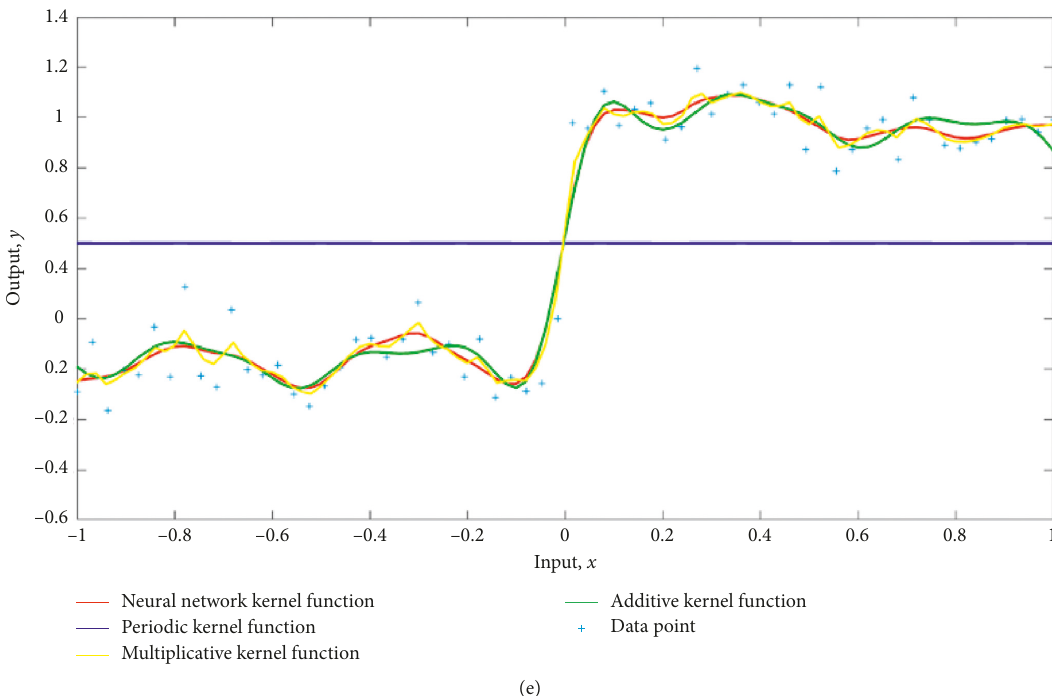
Figure 2: Mis-specification example. (a) Neural network. (b) Periodic. (c) Sum of two kernel functions. (d) Product of two kernel functions. (e) Comparison of four kinds of kernel